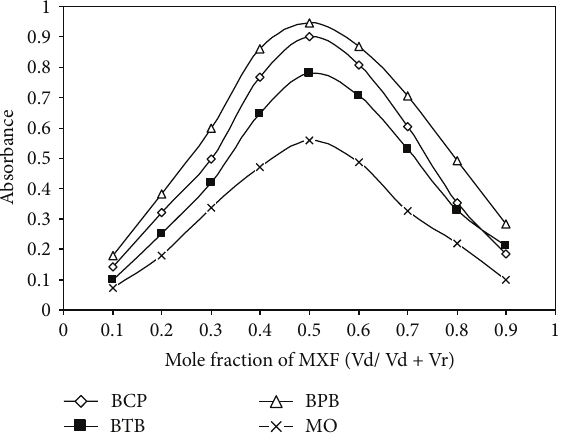
Figure 3: Job’s method of continuous variation graph for the reaction of MXF with dyes BCP, BPB, BTB, and MO, [drug] = [dye] = 5.0 × 10 −4